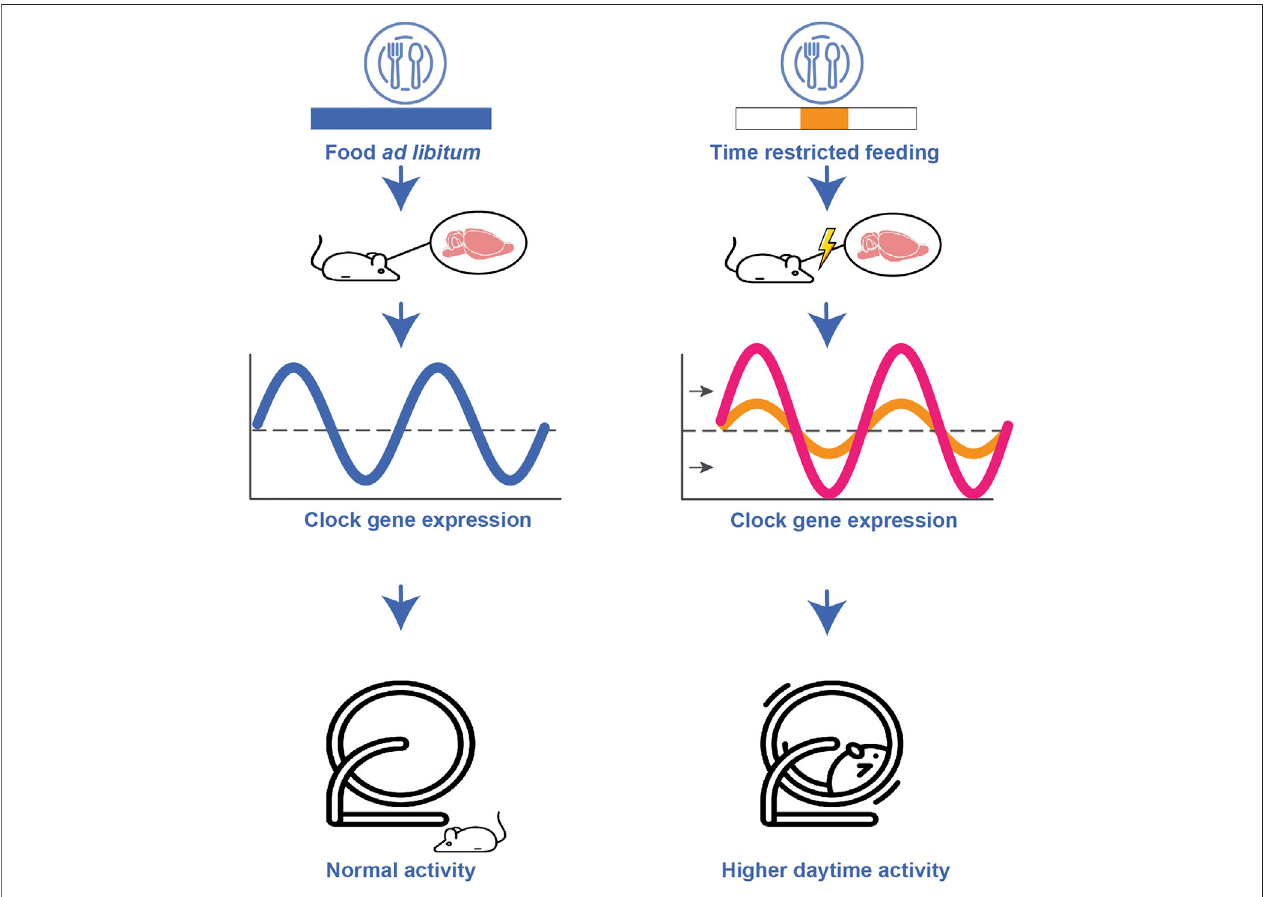
FIGURE 4 | Schematic representation of the impact of altered food schedules on the circadian clock. Restricted feeding during daytime leads to a shifted, attenuatedor increased clockgeneexpressiondepending on brainregion. Furthermore,restricted feedingduring daytime results inhigher daytime activity comparedto the normally low daytime